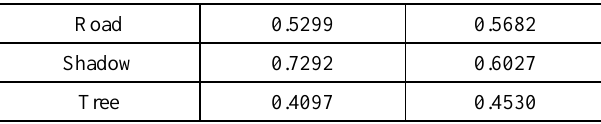
Table 1. Classification accuracy for the two methods.